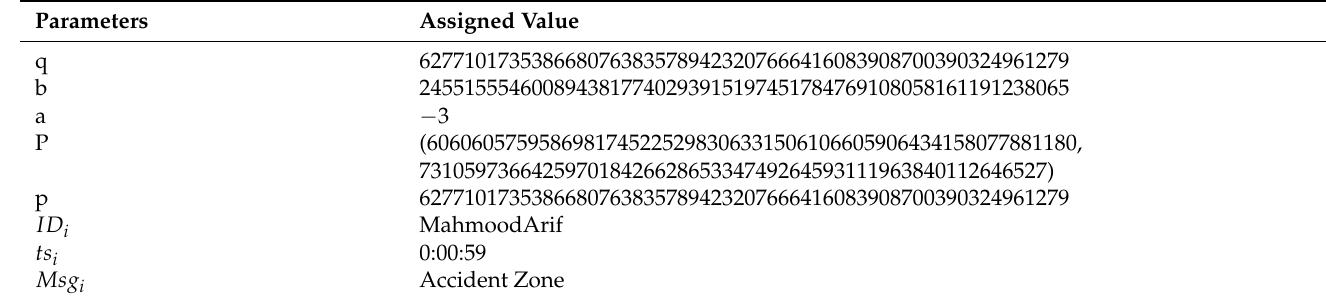
Table 2. Parameters and their corresponding example